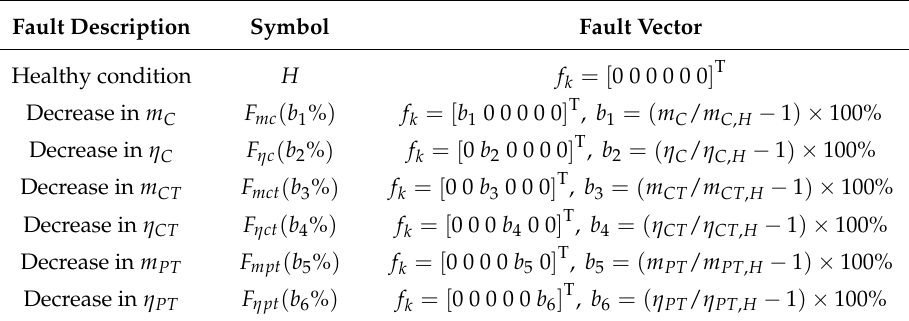
Figure 4. FCM based FDI approach simulation testing. Table 2. Typical single gas path faults.